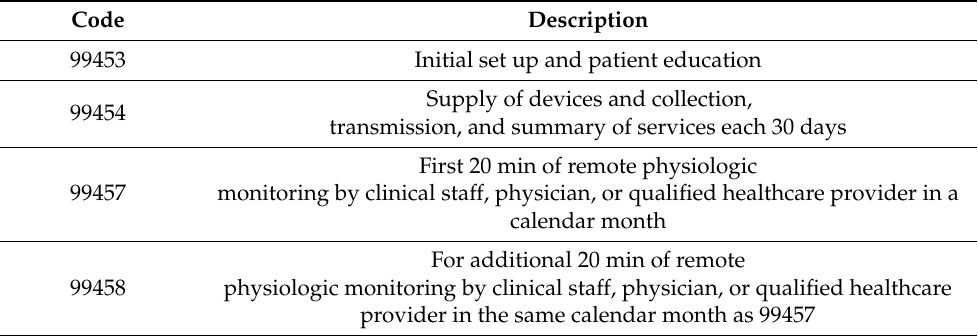
Table 1. List of RPM codes and their descriptions. See Text S1 for further